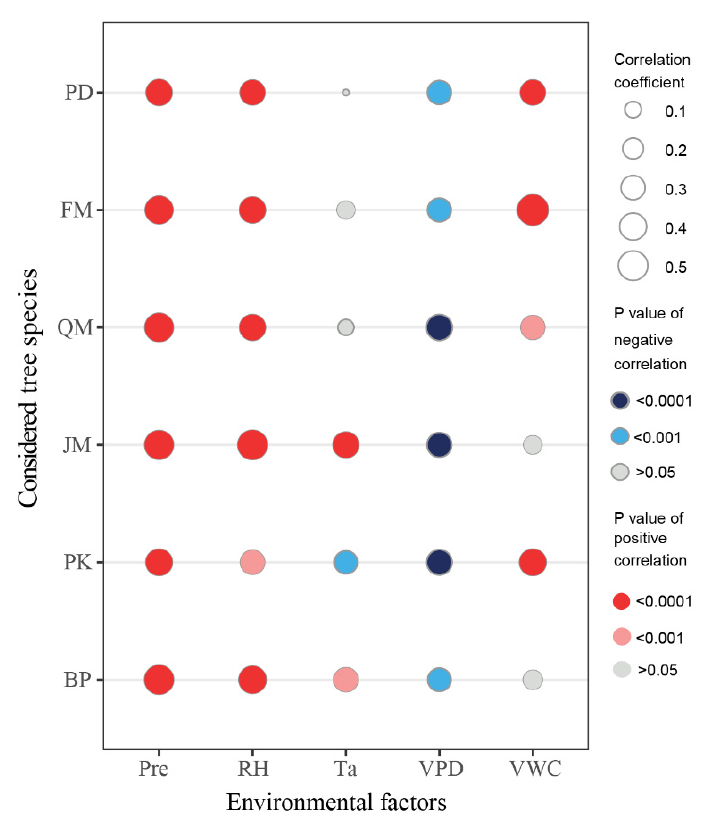
Figure 3. Relationship between stem radial change (SRC) of six tree species and environmental factors. The data are from the growth seasons of the six tree species (DOY121-273). FM: Fraxinus mandshurica